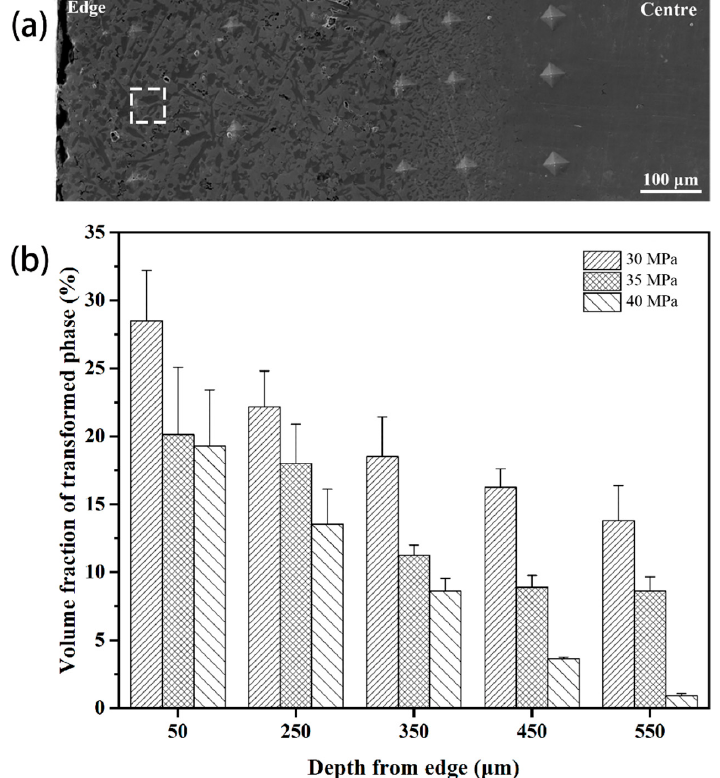
Figure 3. Scanning electron microscopy (SEM) image ( a ) and volume fraction of the transformed phase ( b ) of the FeCoCrNiMo HEA after sintering at 1150 °C and different sintering pressures. The mark shows the approximate position of the energy-dispersive X-ray (EDX) map.